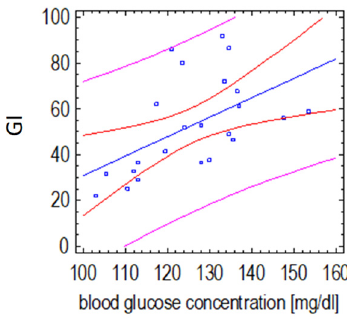
Figure 5. Relationship of the GI value of instant noodle soup with a plant-based supplement and postprandial glucose concentration 30 min after its consumption (Spearman’s correlation test). (the red lines define prediction limits; the pink lines define confidence limits (95%); the blue dots are the results obtained).